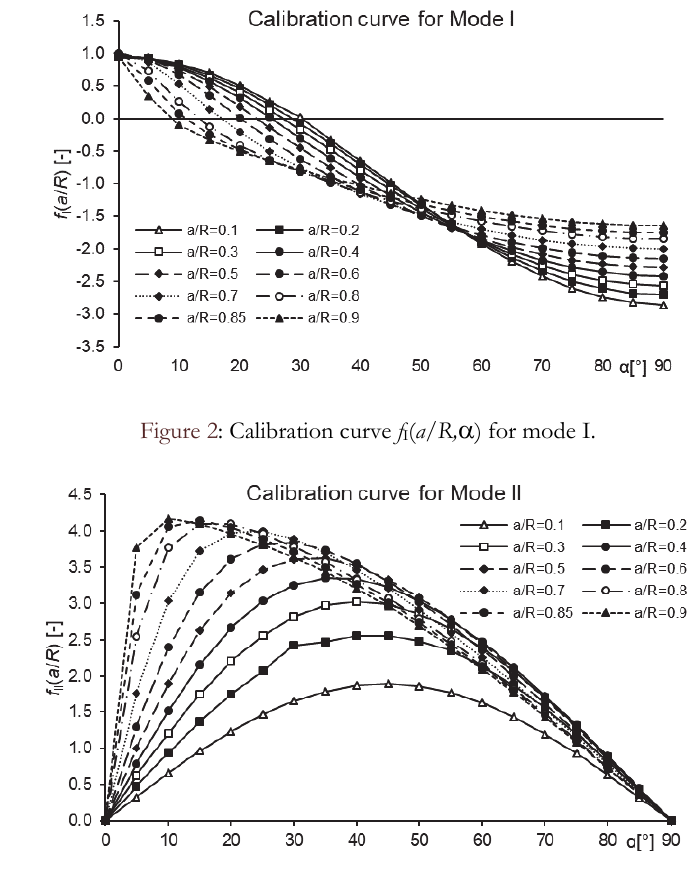
Figure 3: Calibration curve f II ( a / R, α ) for mode II.